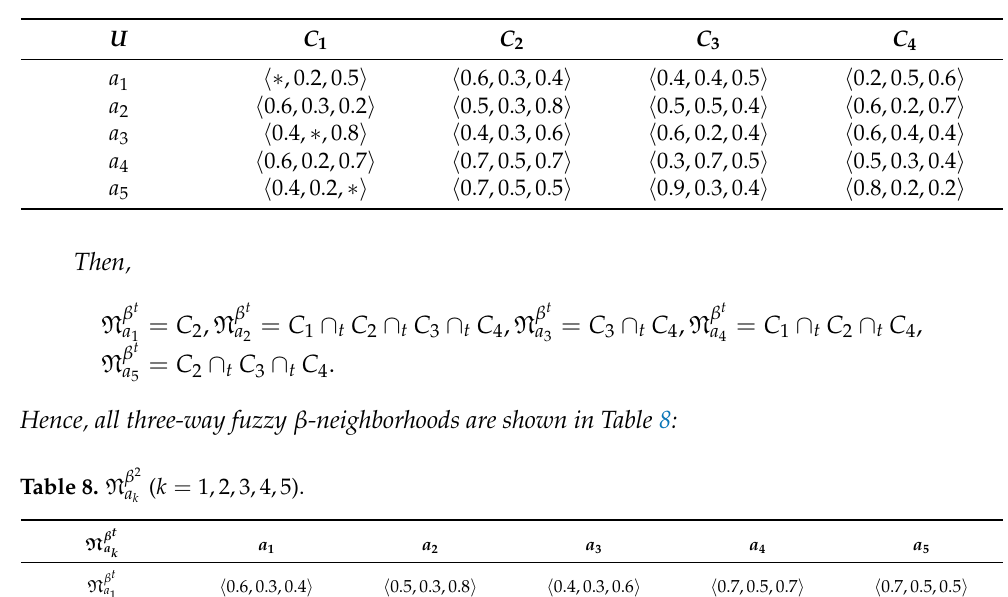
Table 7. A three-way fuzzy β -covering (cid:98) C .